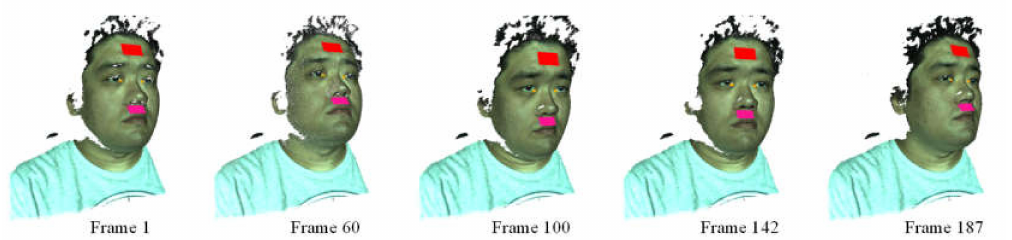
Figure 5. 3D face tracking and registration of 3D